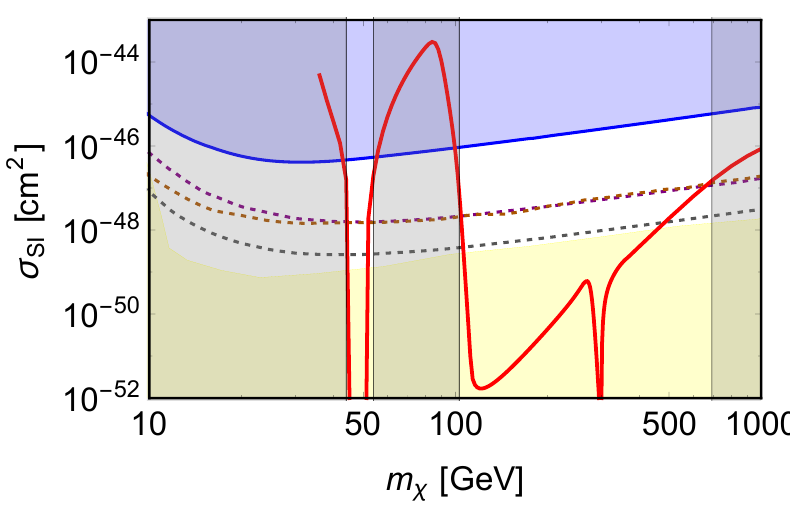
Figure 8 . The red solid line shows the predicted SI cross section of this model with m m A = 600 GeV, (cid:18) = 0 : 1, t (cid:12) = 10, c 1 = 0, and c 2 = 1. The regions where g (cid:31) > 1 are shown as the gray region. The blue region is excluded by the latest result of the XENON1T experiment [3]. The purple, brown, and gray dotted lines indicate the future sensitivities of the XENONnT [20], LZ [21], and DARWIN experiments [22], respectively. The yellow region is below the neutrino (cid:13)oor